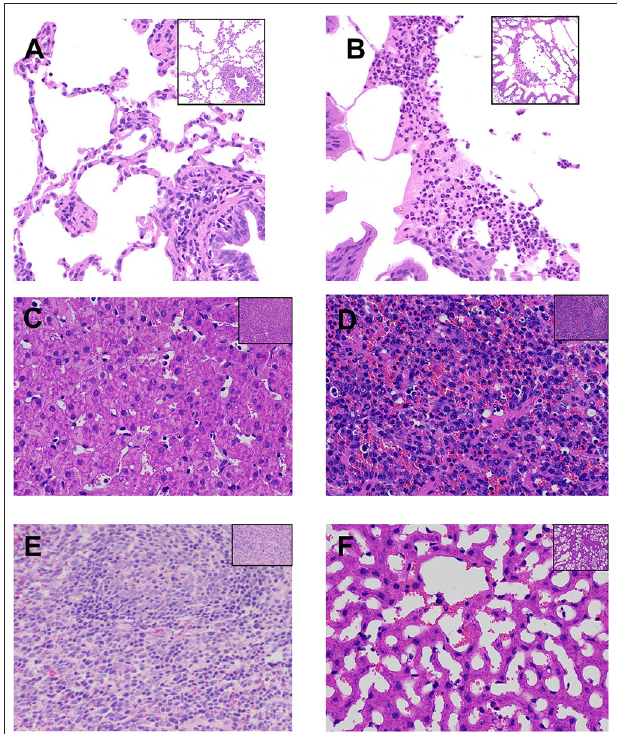
FIGURE 1 | Histopathological analysis of lesions in the lungs, liver, and spleen of goats from the two experimental groups. (A,C,E) Lung, liver, and spleen tissues, respectively, from goats belonging to the uninfected control (CK) group. (B D,F) Lung, liver, and spleen tissues, respectively, from goats belonging to the Pasteurella multocida -challenged group. All tissues were strained with hematoxylin and eosin. Magnification, × 200 in the top right corner figure and × 400 in the larger-version figure. (B) Shows that some exfoliated alveolar epithelial cells and a large number of neutrophils gathered in the alveolar cavity, and some neutrophils degenerated and necrotized, forming abscess. (D) Shows that the normal structure of the liver tissue was lost, and the sinusoidal space was highly dilated and vacuolated, which compressed the hepatocyte cord and atrophied, and some hepatocytes were degenerated and necrotized. (F) Shows that lymphocyte proliferation and congestion could be seen in the spleen tissue, showing the characteristics of acute splenitis.